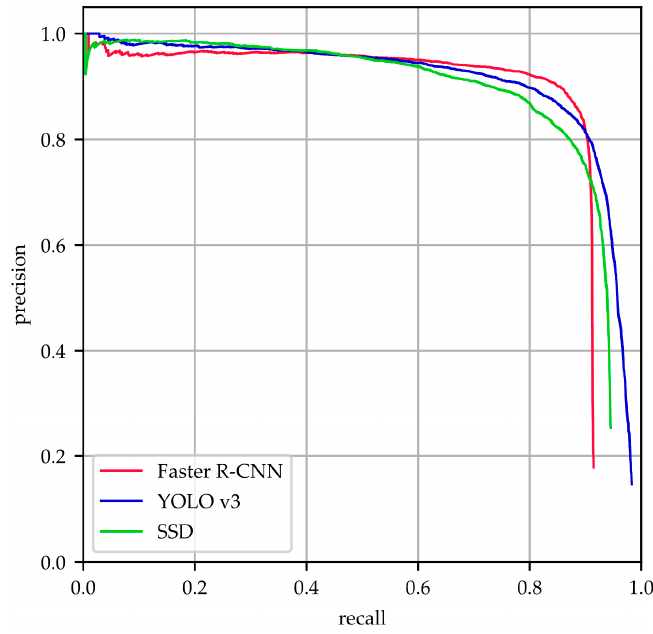
Figure 6. Precision-recall curves (PRCs) for Faster RCNN, YOLO v3 and SSD.